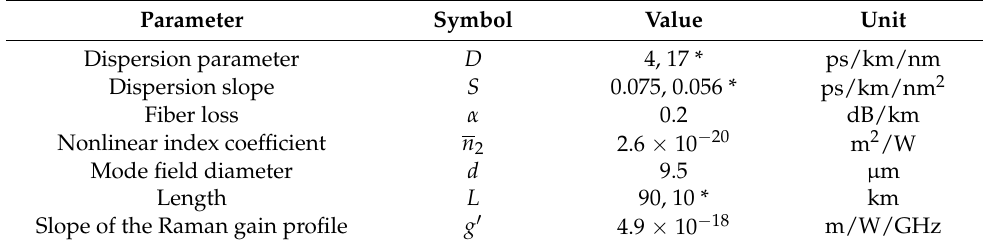
Table 3. Parameters of the optical fiber. Parameter Symbol Value Unit Dispersion